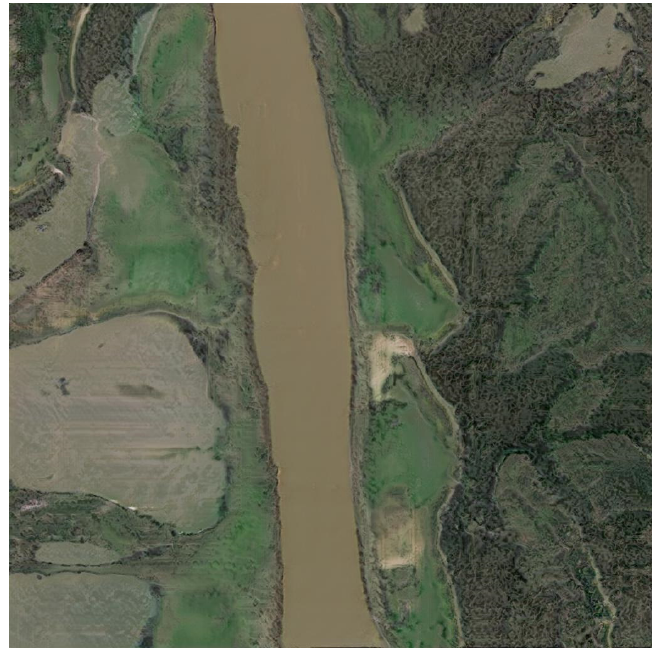
Figure 7. An example output of river image generation GAN [55].